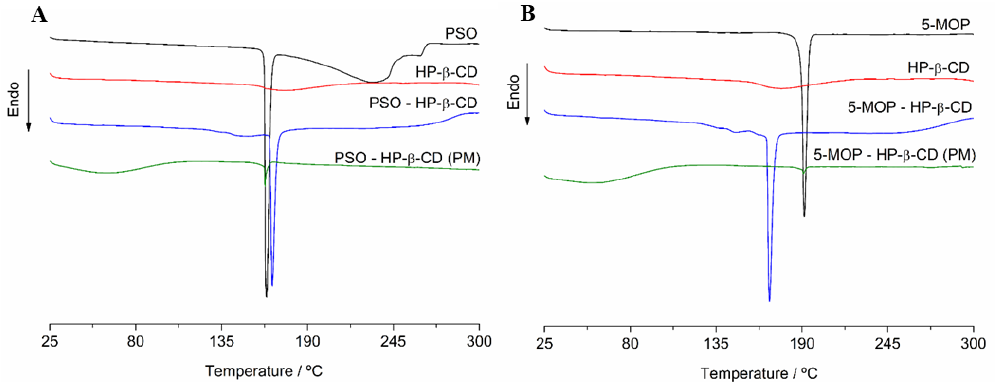
Figure 6. ( A ) Differential scanning calorimetry thermograms of PSO, HP- β -CD, physical mixture, and PSO-HP- β -CD inclusion complex (1:1). ( B ) Differential scanning calorimetry thermograms of 5-MOP, HP- β -CD, physical mixture (PM), and 5-MOP-HP- β -CD inclusion complex (1:1). DSC thermal curve of the putative inclusion complexes (PSO-HP- β -CD or